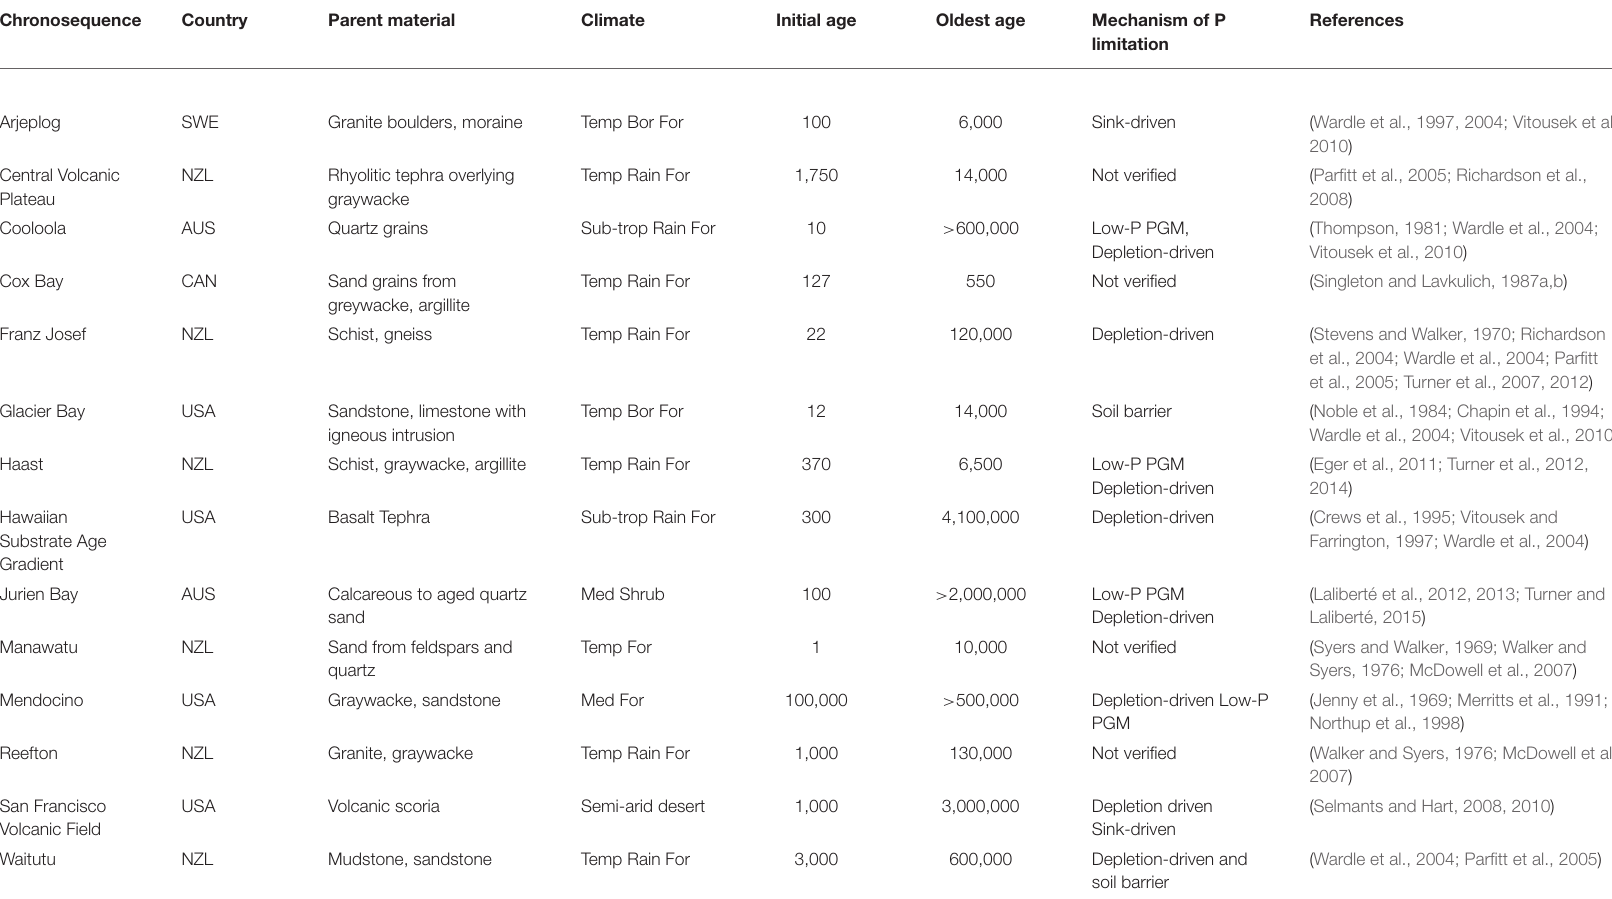
TABLE 1 | Chronosequences exhibiting phosphorus (P) decline with age, country, parent material, climate, initial and oldest ages, and the mechanism of P limitation.